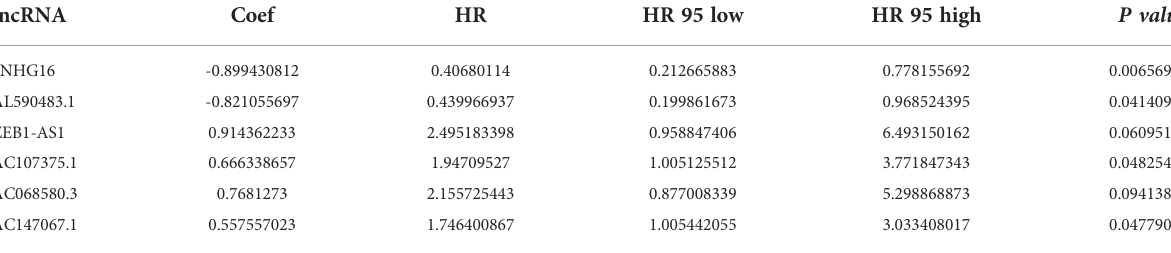
TABLE 2 Multivariate Cox regression analyses of OS in patients with colorectal